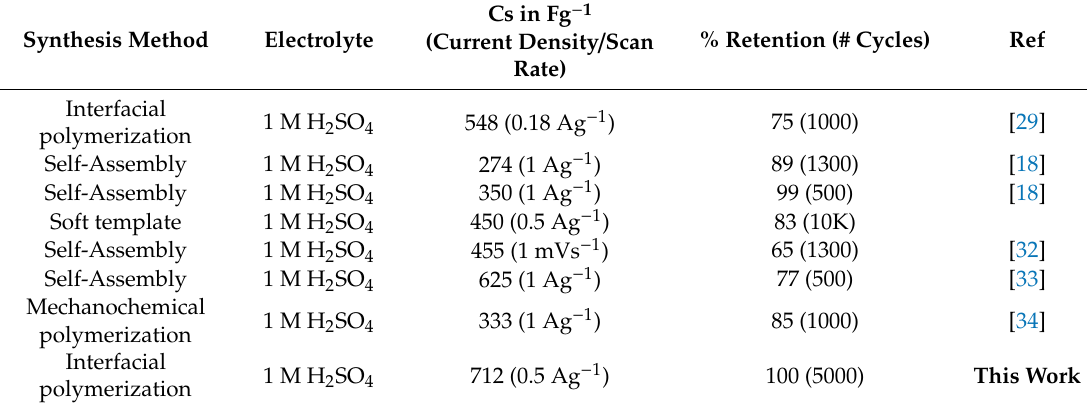
Table 1. Comparison of specific capacitance values and percentage retention of polyaniline synthesized via di ff erent polymerization